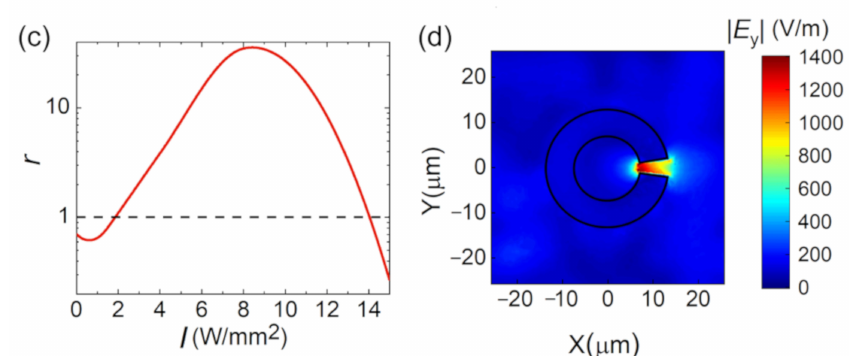
Figure 7. ( a ) Reflection amplitude of graphene-dielectric reflective metasurface under di ff erent pump intensities. ( b ) Real conductivity of graphene under di ff erent pump intensities. ( c ) The fitting curve for the reflection peak amplitude as a function of optical pump intensity. ( d ) Electric field distribution for graphene-dielectric reflective metasurface in the xy plane at 3.38 THz ( I = 8 W / mm 2